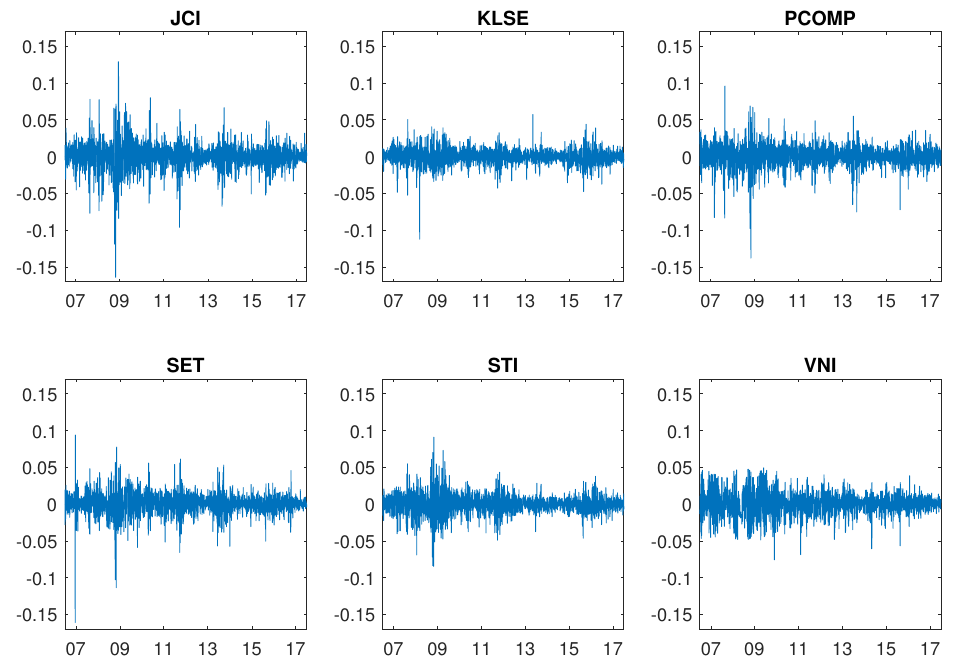
Figure 1. Log-returns for the period 1 July 2006–30 June